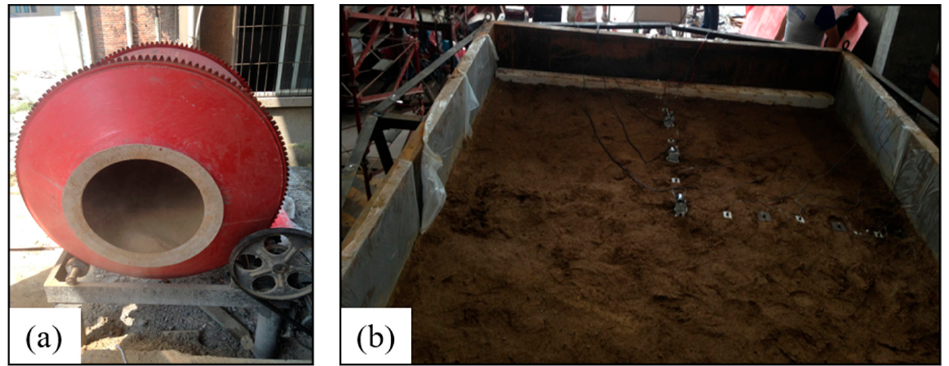
Figure 11. Stirring and filling of sawdust soil: ( a ) Sawdust soil stirring, ( b ) The sawdust soil is filled in the model box.